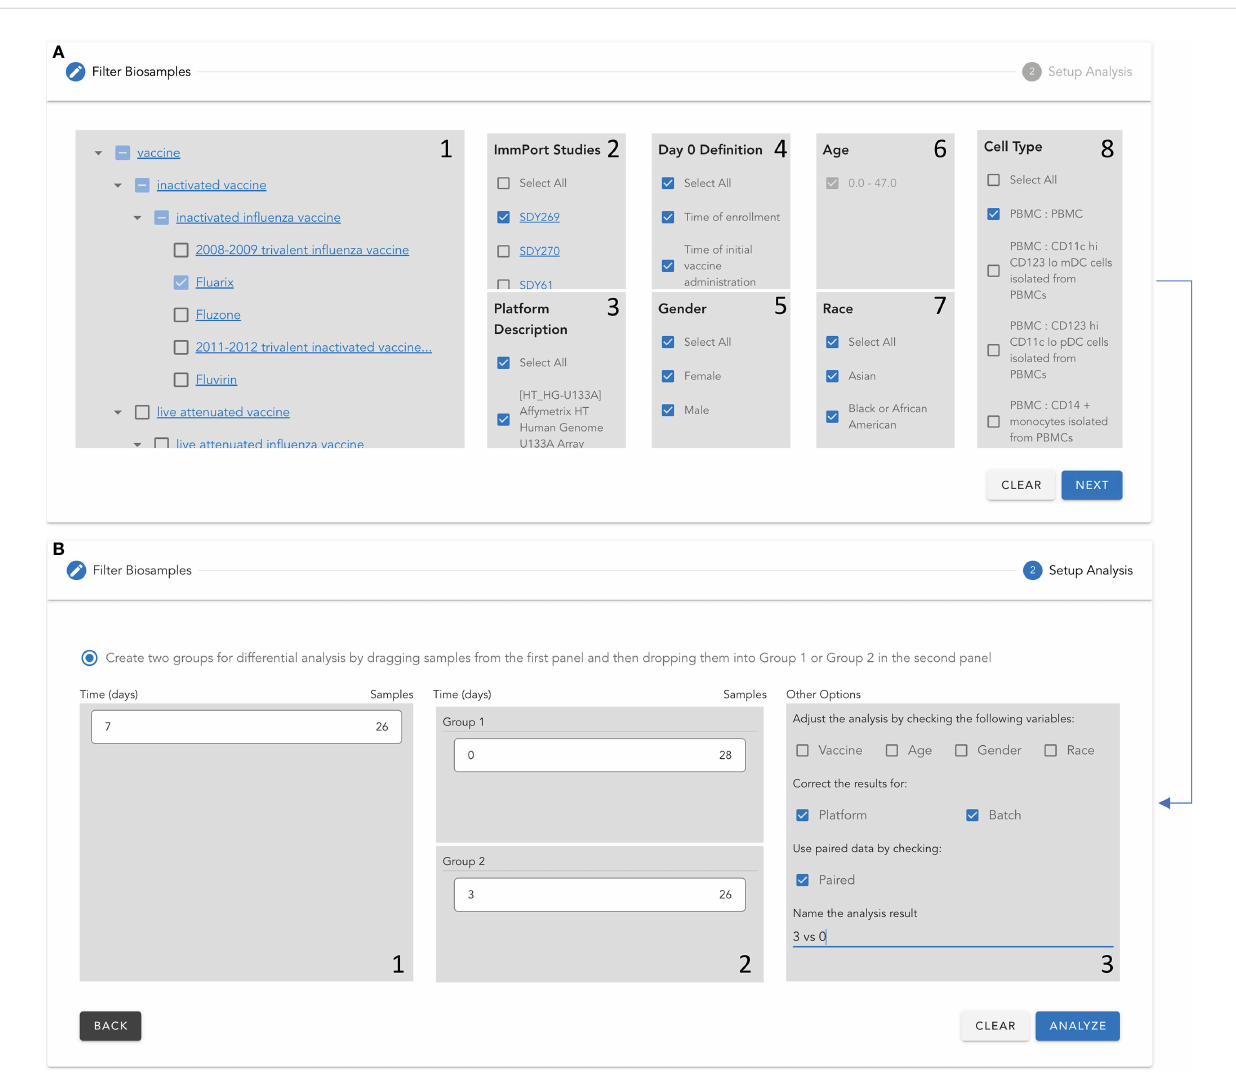
FIGURE 6 Two-step protocol to set up a differential gene expression analysis for vaccine response using VIGET. Step 1 (A) Select samples based on vaccine (A.1), ImmPort studies (A.2), platform used for microarray screenings (A.3), day 0 de fi nition as annotated in ImmPort (A.4), gender (A.5), age (A.6), races (A.7) and cell types and subtypes (A.8). Step 2 (B) create two groups based on vaccination times listed in B.1 via dragging and dropping into B.2. The user can further adjust the analysis model by including confounding variables, correcting the results for platforms and choosing the paired